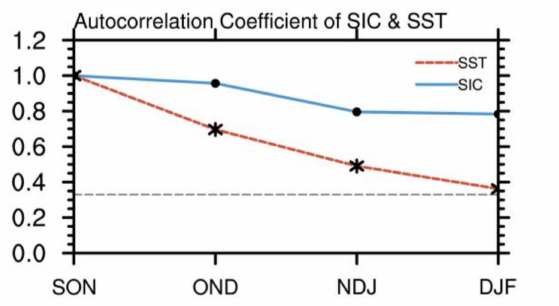
Figure 12. Time series of autocorrelation coefficient of SIC (the blue solid line) and SST (the red dashed line) in SON (Sep., Oct., Nov.), OND (Oct., Nov., Dec.), NDJ (Nov., Dec., Jan.) and DJF (Dec., Jan., Feb.) in Barents-Kara Seas region. The gray reference line indicates significance at the 95% level from the t